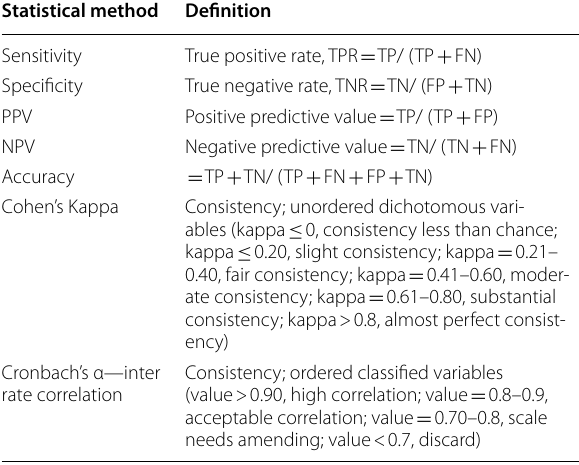
Table 1 Statistical analysis Table 2 Clinical and pathological characteristics of the